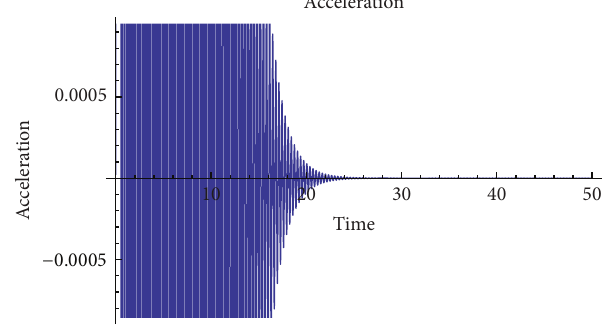
Figure 2: The inconsistent behavior of velocity for 𝜀 = 10, 𝐵 = 50, ] = 0 .